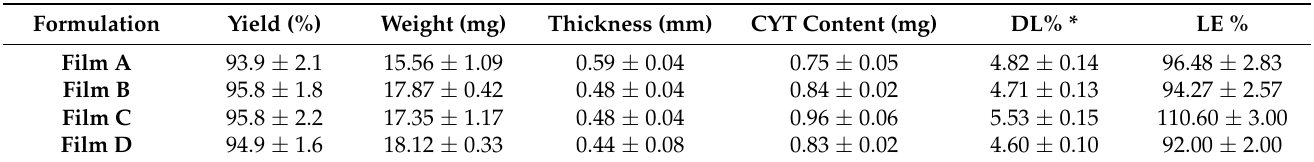
Table 4. Characterization of the CYT-loaded buccal films: yield % of the solvent casting method ( n = 3), weight (mg), thickness (mm), CYT content (mg), drug loading % (DL%) and loading